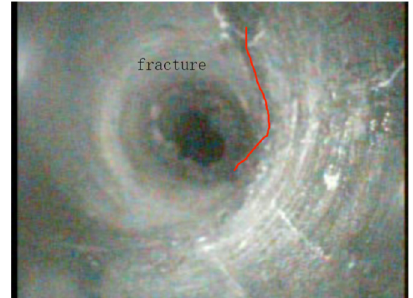
Figure 2. Peeping results of strata before mining in No. 1 hole 29 m away from the working face.